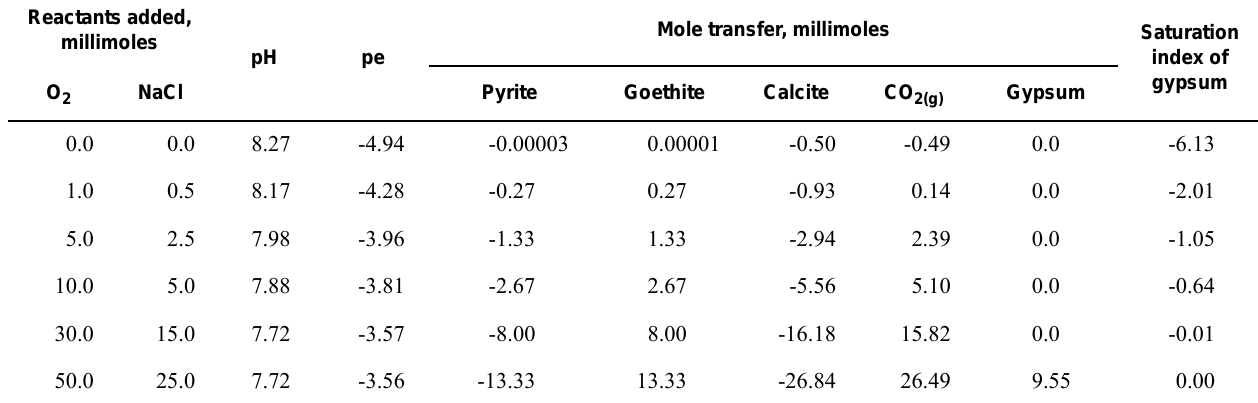
Table 20. Selected results for example